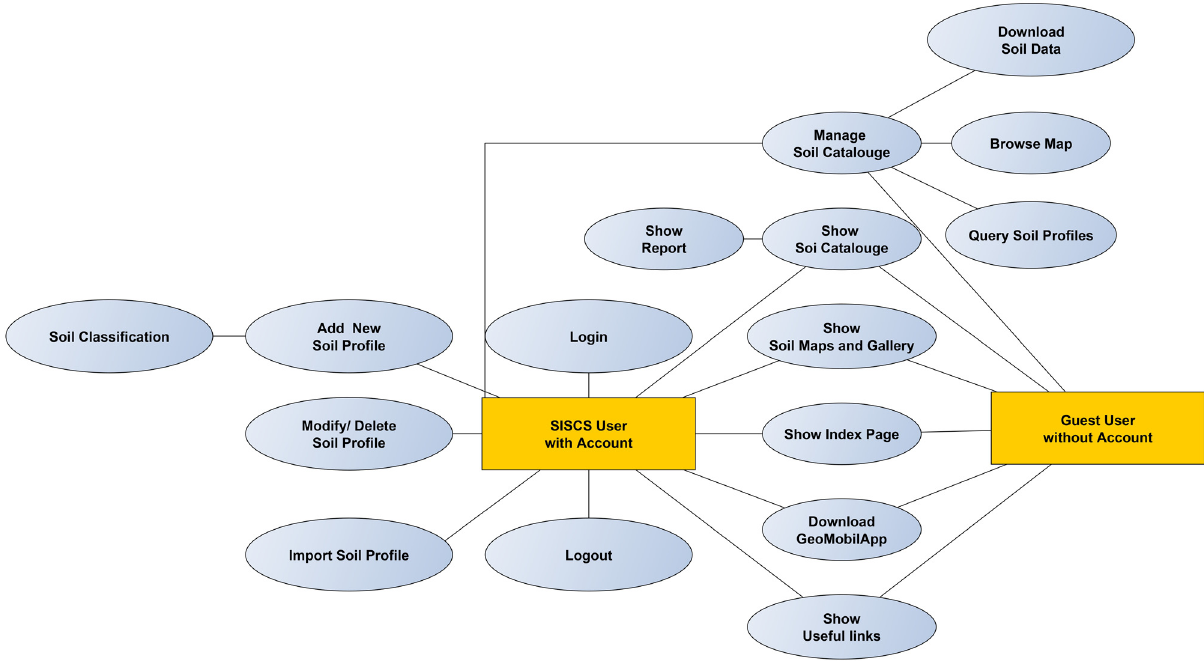
Figure 1: Use Case diagram of SISCS User and Guest.